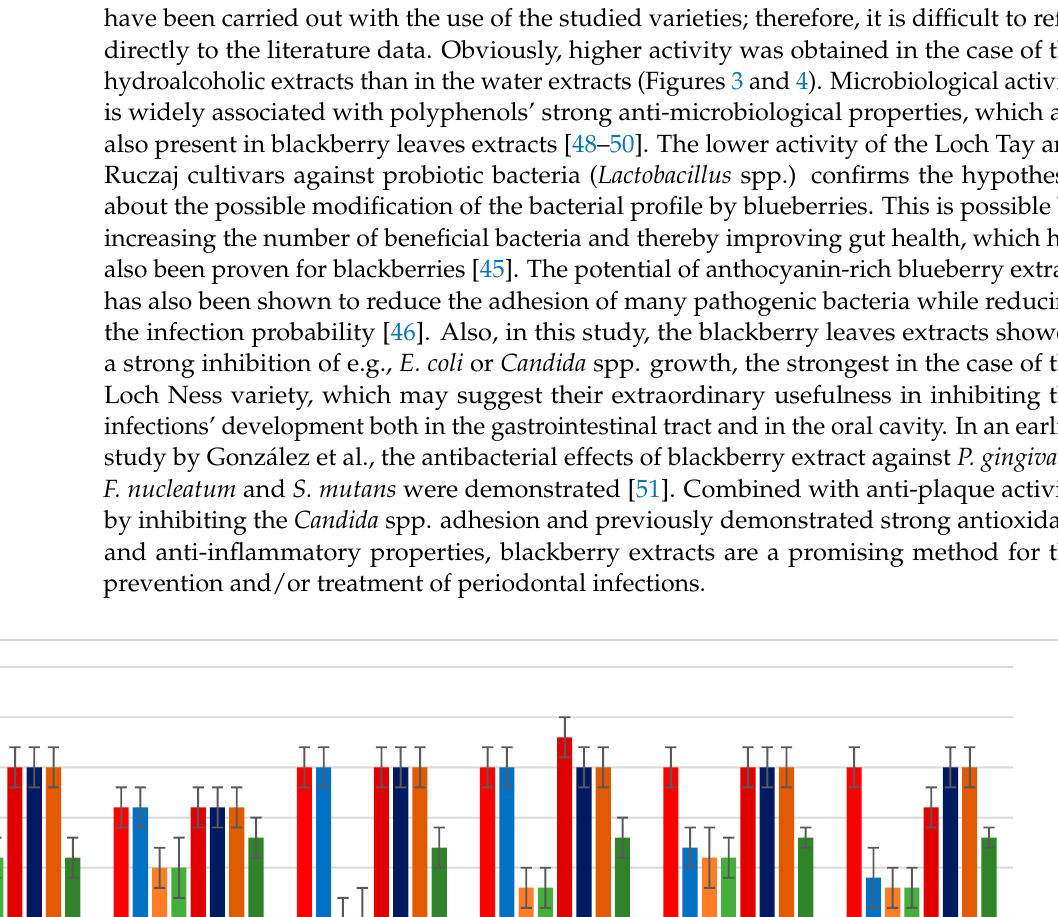
Figure 4. Microbiological activity of blackberry leaves extracts in their initial concentrations on potentially pathogenic microorganisms. Error bars define the SD values.